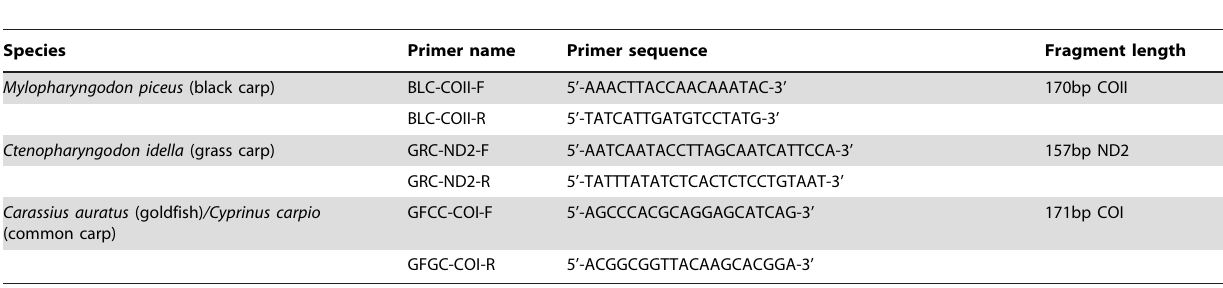
Table 2. Species-specific PCR primer sequences designed to amplify short fragments of mitochondrial DNA of black carp and grass carp, respectively, for this